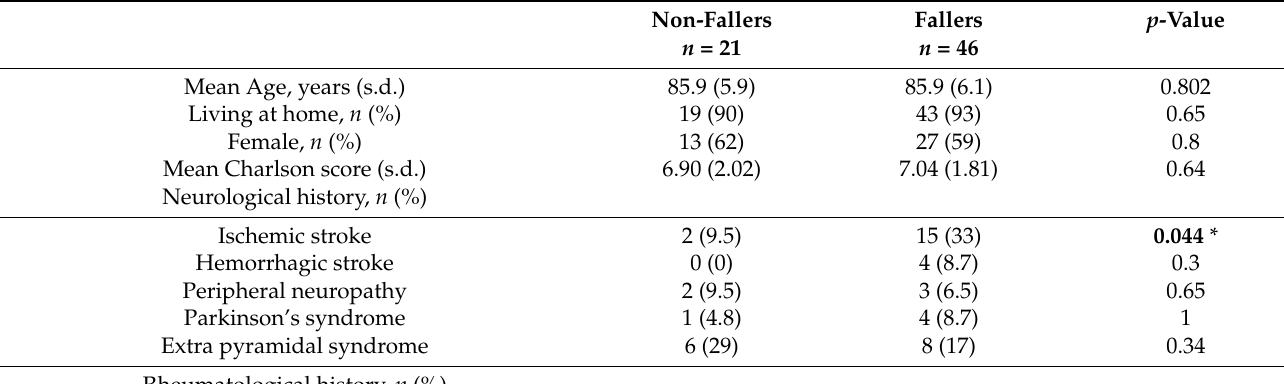
Table 1. Demographic characteristics of the study population.